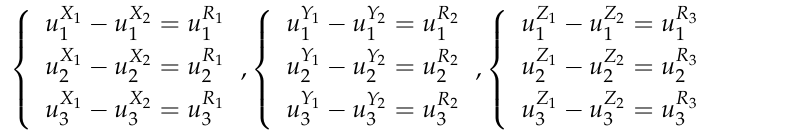
Figure 7. Meshing and components of the RVE. and Z are used to represent the node sets of the front and rear 2 boundary surfaces, left and right interfaces, and upper and lower boundary surfaces of the REV, respectively. and are used to represent the reference points associ- ated with the corresponding boundary surfaces. Then the constraint equation of the peri- odic boundary condition can be expressed as Equation (3):